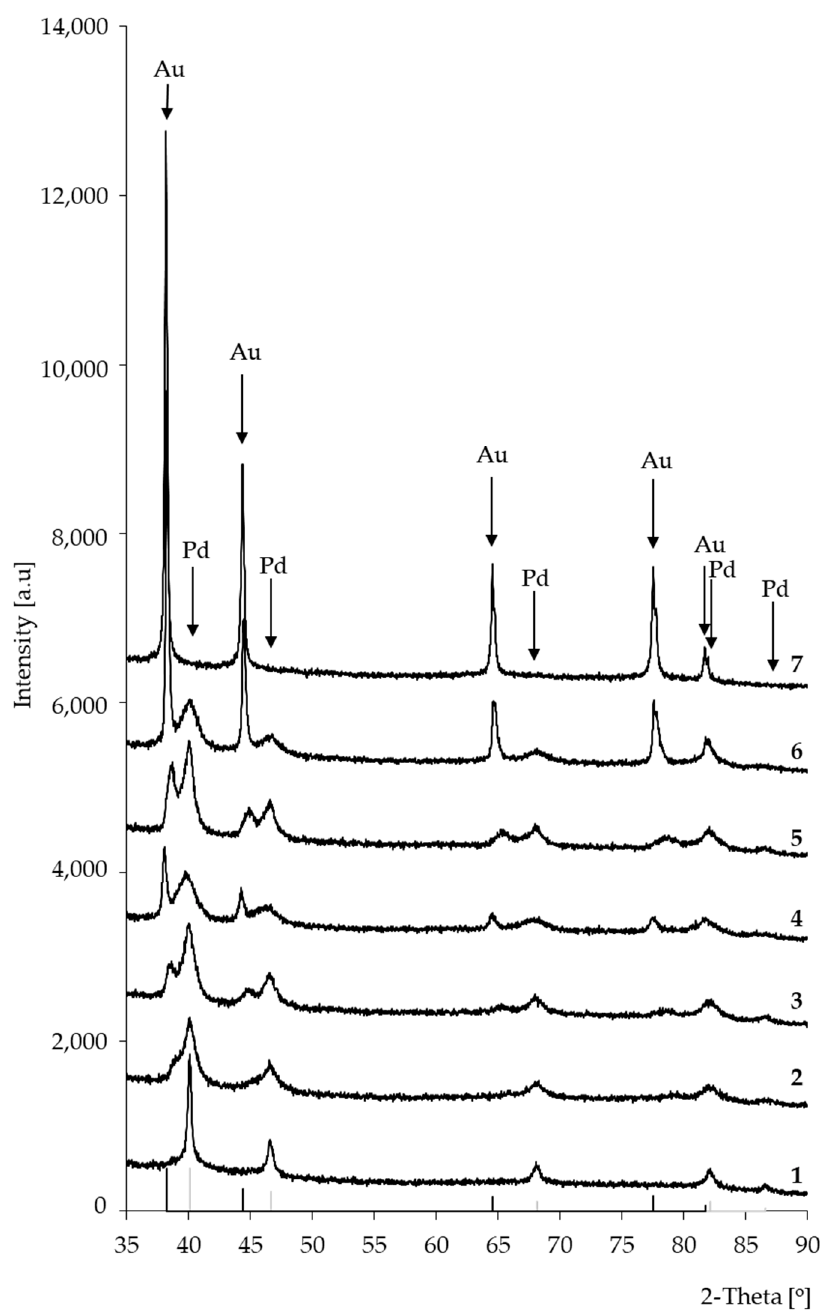
X-ray di ff raction patterns of Pd-Au / SiO 2 : (1) 5%Pd / SiO 2 ; (2) 5%Pd-0.2%Au / SiO 2 ; Figure 2. X-ray diffraction patterns of Pd-Au/SiO 2 : (1) 5%Pd/SiO 2 ; (2) 5%Pd-0.2%Au/SiO 2 ; (3) 5%Pd- 0.5%Au/SiO 2 ; (4) 5%Pd-1%Au/SiO 2 ; (5) 5%Pd-2%Au/SiO 2 ; (6) 5%Pd-5%Au/SiO 2 ; (7) 5%Au/SiO 2 . (7) 5%Au / SiO 2 . Bimetallic catalysts were activated in hydrogen atmosphere for 2 h at 300 ◦ Bimetallic catalysts were activated in hydrogen atmosphere for 2 h at 300 °C.